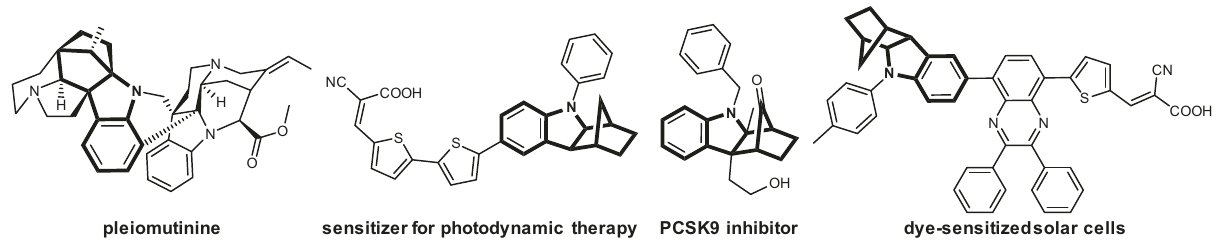
Fig. 1 Presence of Hexahydromethanocarbazole. Hexahydromethanocarbazole moieties present in natural products, materials, solar cells, and potential